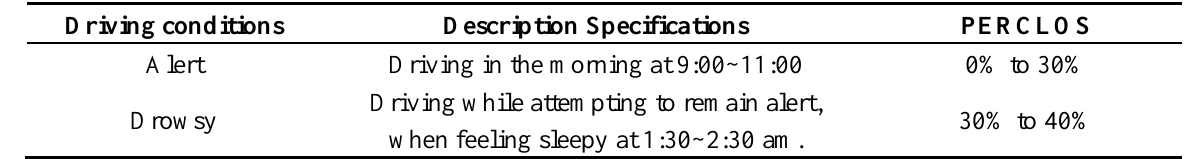
Table 3. Summary of the two different driving